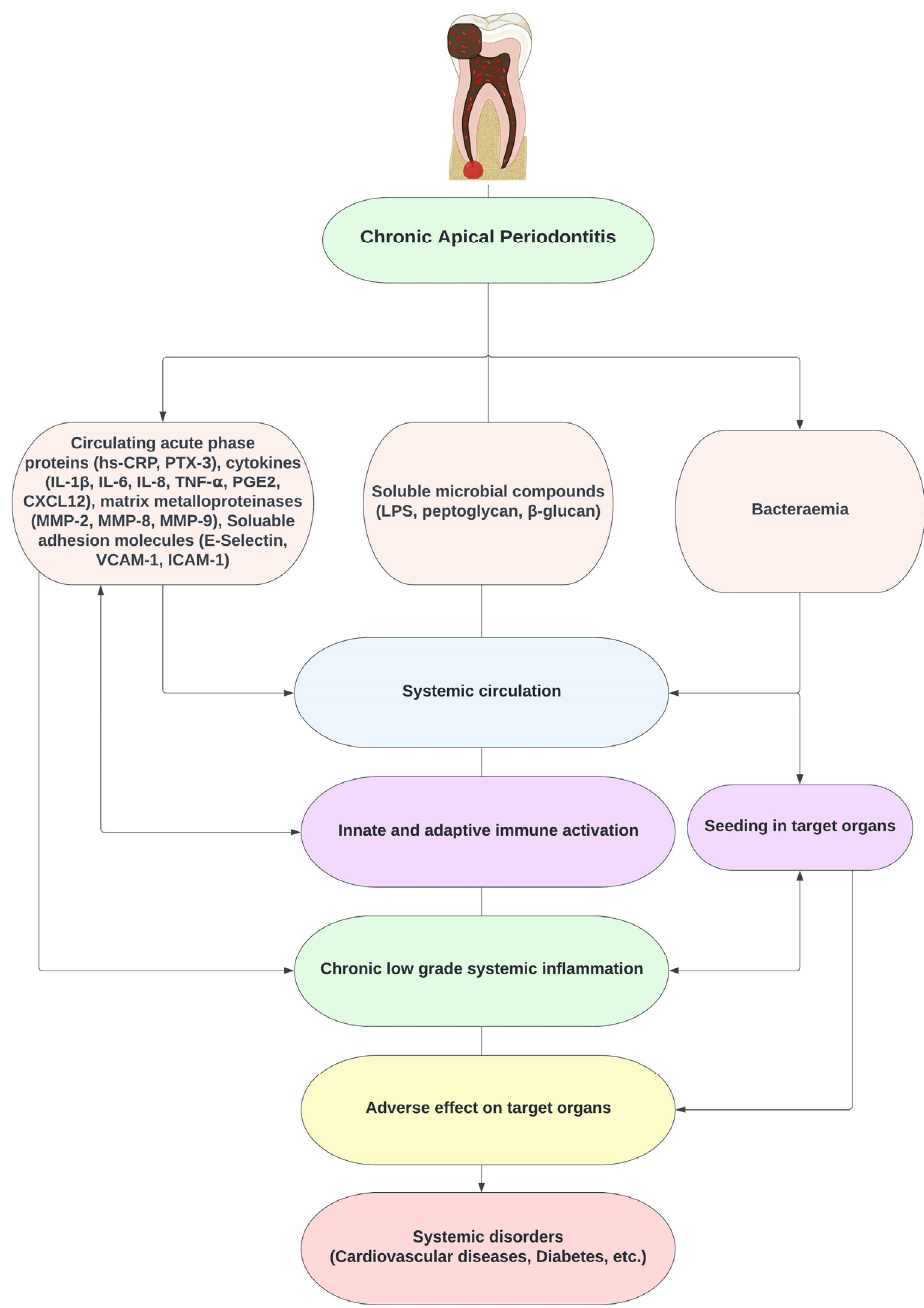
Figure 2. Pathways linking endodontic bacteria to systemic diseases.